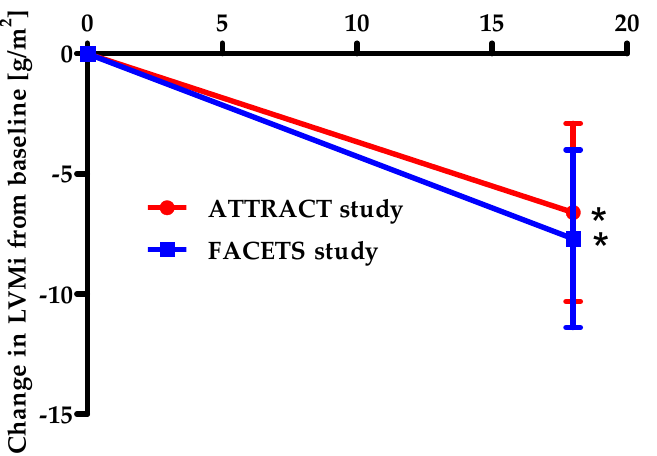
Figure 3. Differences in echocardiographic-derived Left-ventricular-mass (LVM) index change from baseline to at least 18 months on Migalastat [31,32]. Red line: In the ATTRACT study, difference to month 18 in mITT patients (all randomized, treated patients with amenable mutations). LVMi decreased significantly (95%CI; 6.6 ( − 11.0 to − 2.2 *) in patients switched from enzyme replacement therapy (ERT) to Migalastat [32]. Blue line: in the FACETS study. Patients in the intention-to-treat population who had suitable mutant α -galactosidase, underwent echocardiography baseline and post-baseline, and received Migalastat for at least 18 months†. Month six was used as the baseline for patients who received placebo for 6 months before switching to Migalastat. LVMi decreased significantly (95%CI; − 7.7 ( − 15.4 to − 0.01 *) [31]. Values are means ± SEM, * The difference from baseline was considered to be significant because the 95% confidence interval did not include zero, †Month 18 or 24 was used as the baseline of the extension study, LVMi, left ventricular mass index, mITT, modified intention-to-treat population, CI, confidence interval.